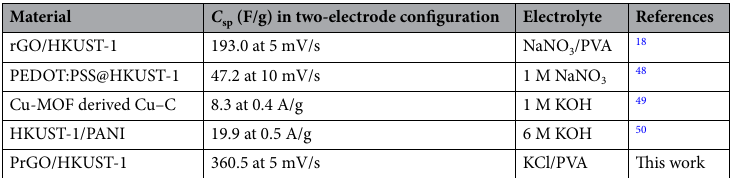
Table 1. Comparison of specific capacitance of proposed symmetric supercapacitor with other reported HKUST-1 based energy storage devices. rGO/HKUST-1: reduced graphene oxide/HKUST-1, PEDOT:PSS@